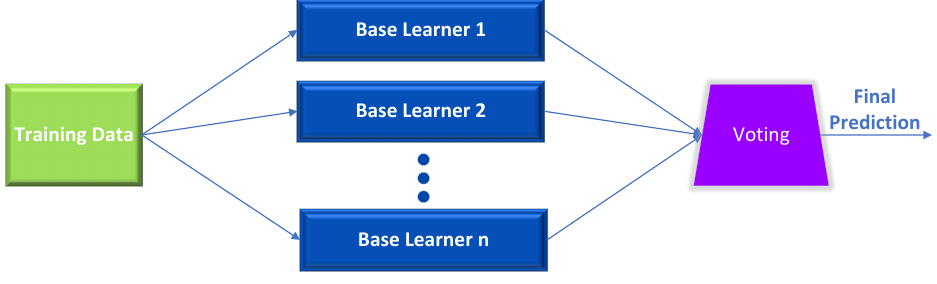
Figure 1. Ensemble learning voting